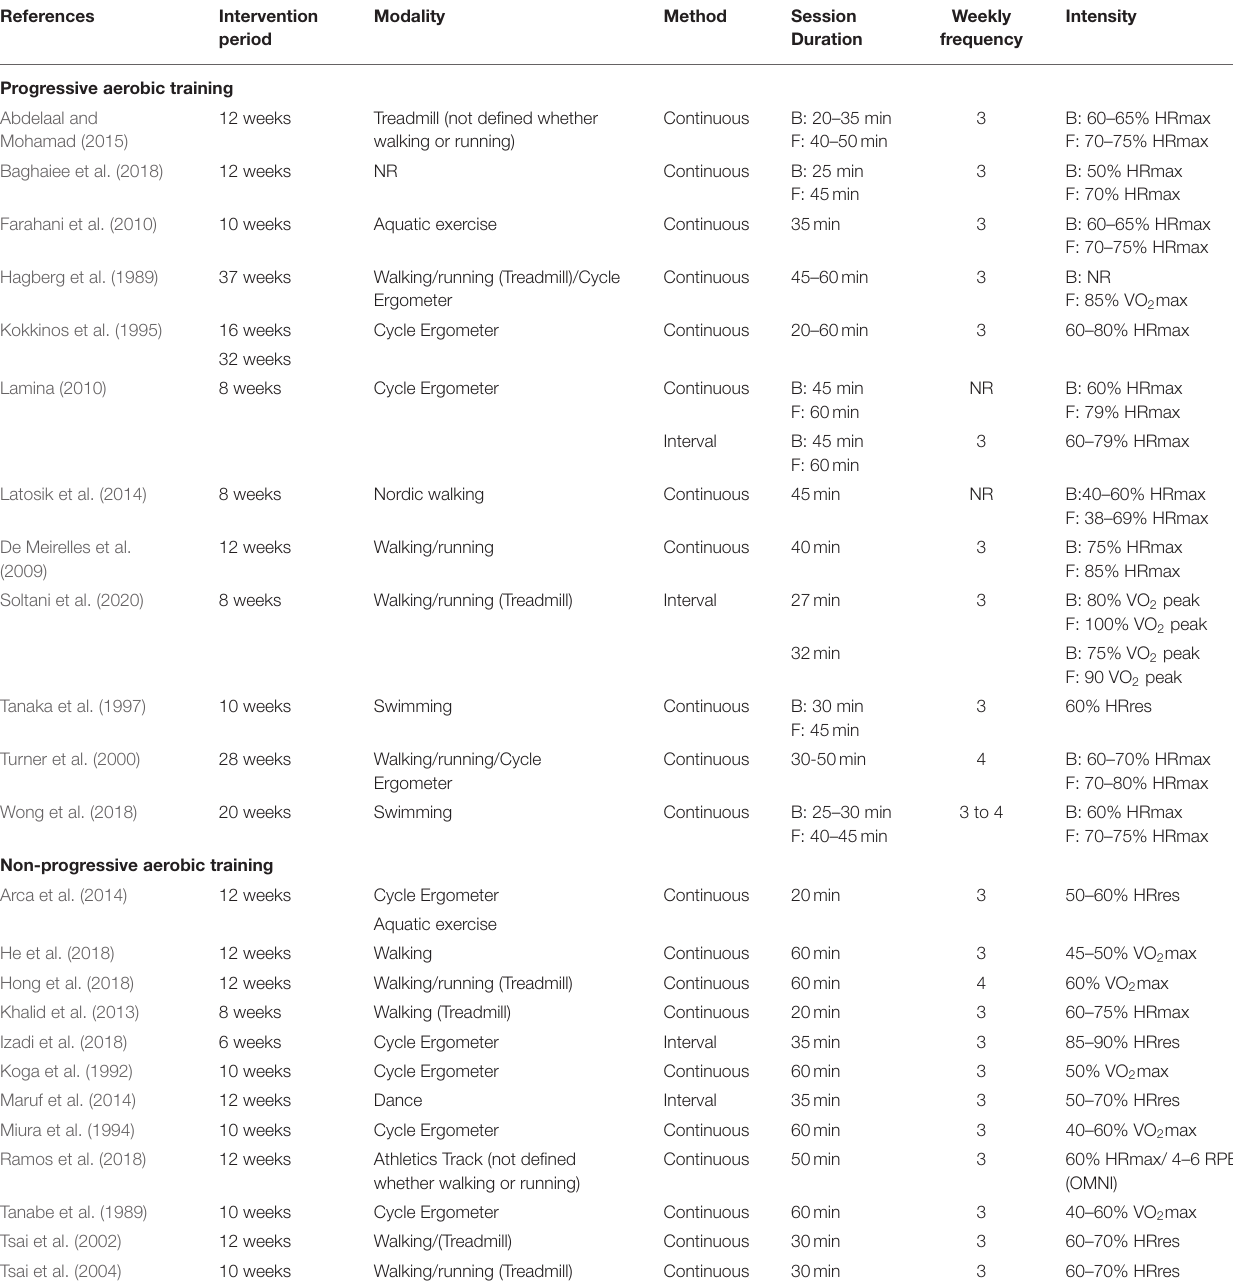
TABLE 2 | Characteristics of the